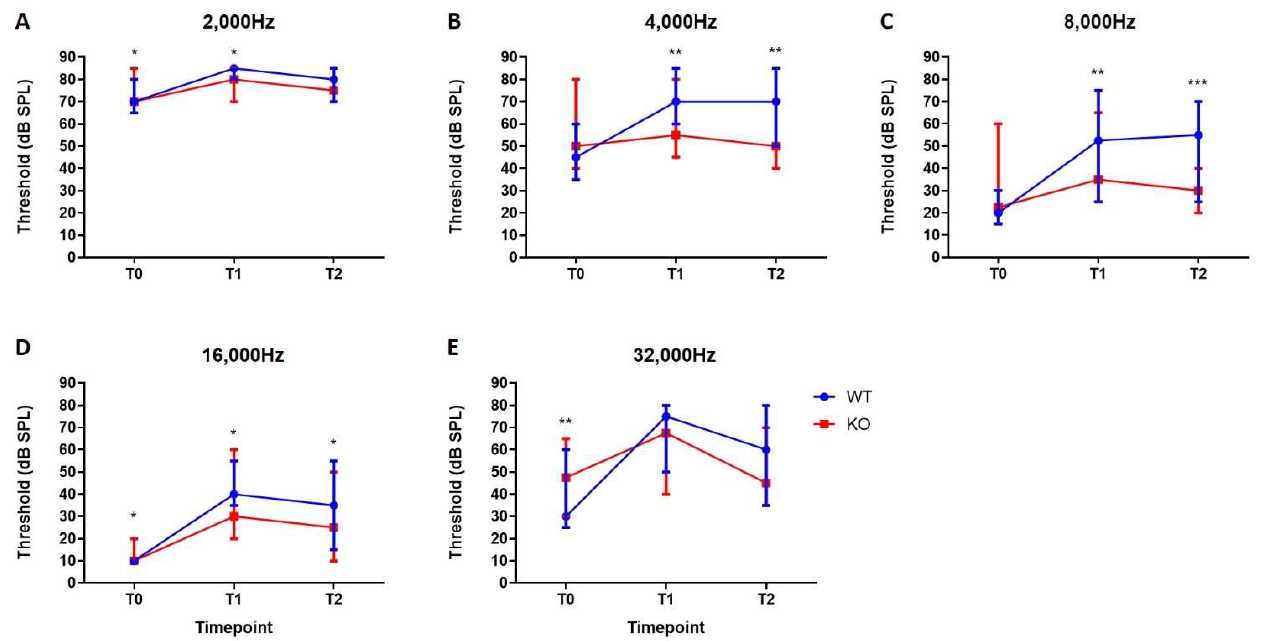
Figure 4. ABR thresholds of Coch − / − ( n = 13) and Coch +/+ mice ( n = 13) at different timepoints (T0 = baseline, T1 = 48 h post-noise, T2 = one-week post-noise) at 2000 Hz ( A ), 4000 Hz ( B ), 8000 Hz ( C ), 16,000 Hz ( D ) and 32,000 Hz ( E ). Data are represented as median with interquartile range. * indicates p < 0.05, ** indicates p < 0.01, *** indicates p < 0.001.